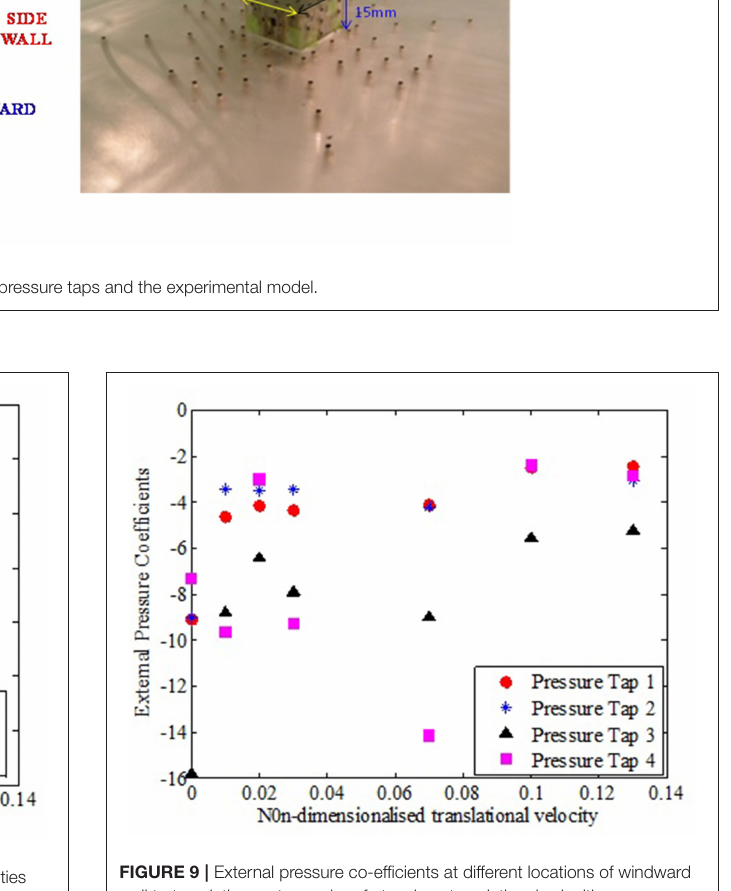
FIGURE 8 | Internal pressure coefficients for various translational velocities and different wall openings.